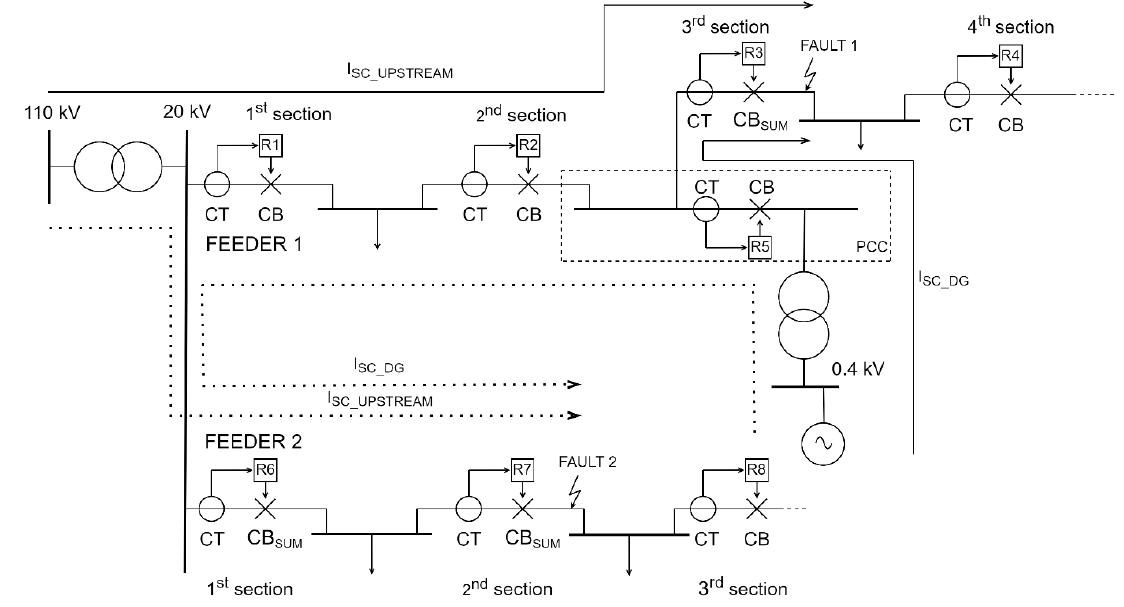
Figure 6. Possible exceeding of breaking and making capacity of the networks’ elements.